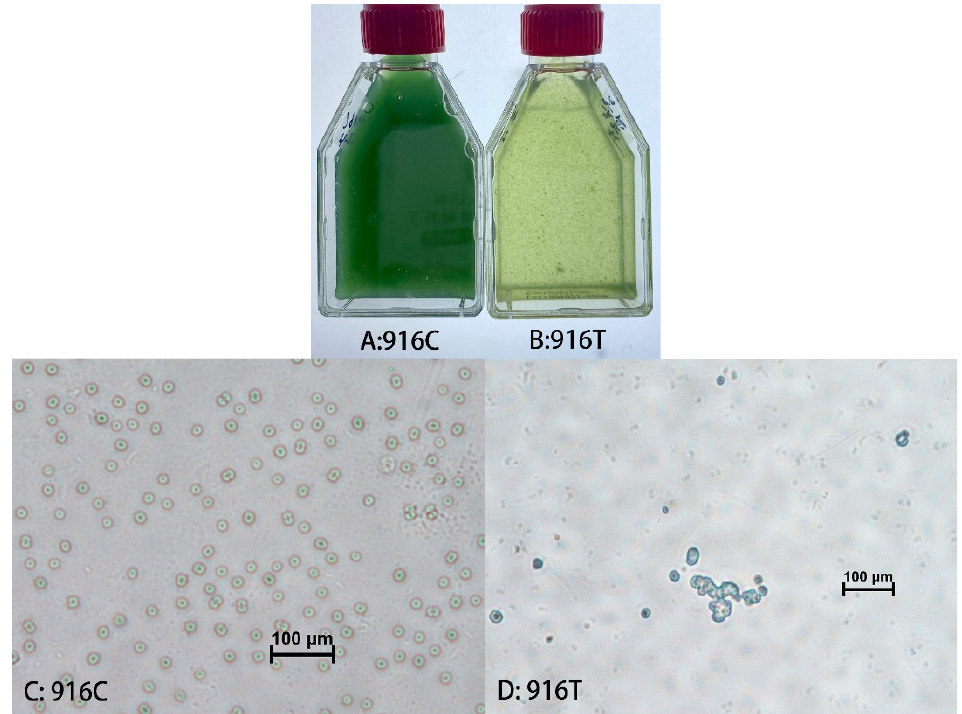
Figure 2. Macro- and micrographs of M. elabens FACHB-916 cultures. ( A ) Macrograph of normal FACHB-916 cultures; ( B ) Macrograph of FACHB-916 co-inoculated with cyanophage Mae-Yong924-1; ( C ) Micrograph of normal FACHB-916 cultures; ( D ) Micrograph of FACHB-916 co-inoculated with cyanophage Mae-Yong924-1.